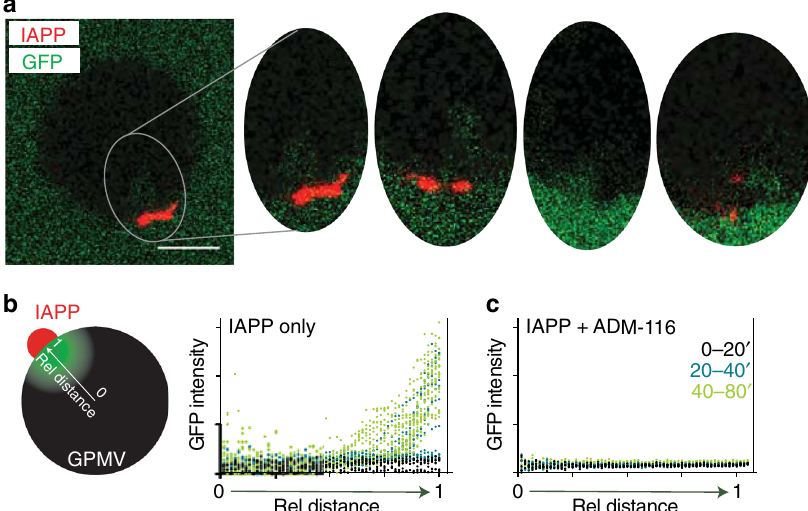
Fig. 3 Poration occurs in discrete bursts at the site of IAPP oligomers. a Confocal fl uorescence imaging of unlabelled GPMVs incubated in GFP containing buffer. Data are collected under conditions matched to Fig. 2b with addition of 200 nM IAPP labelled with Alexa 594. Entry of GFP into the lumen of GPMVs can be seen to occur as discrete bursts near IAPP oligomers (red). Four representative ROIs from independent GPMVs are shown. Note, for the right two ROIs, IAPP is more abundantly present in an adjacent z -slice. Scale bar for is 20 μ m. b , c Kinetic evaluation of plume formation near IAPP oligomers. The intensity of GFP fl uorescence along a radial line, (indicated schematically by an arrow that ends at an IAPP oligomer) was determined in the absence ( b ) or presence ( c ) of equimolar FRET observed here is intermolecular, the narrow peaks re fl ect averaging from oligomer dynamics.